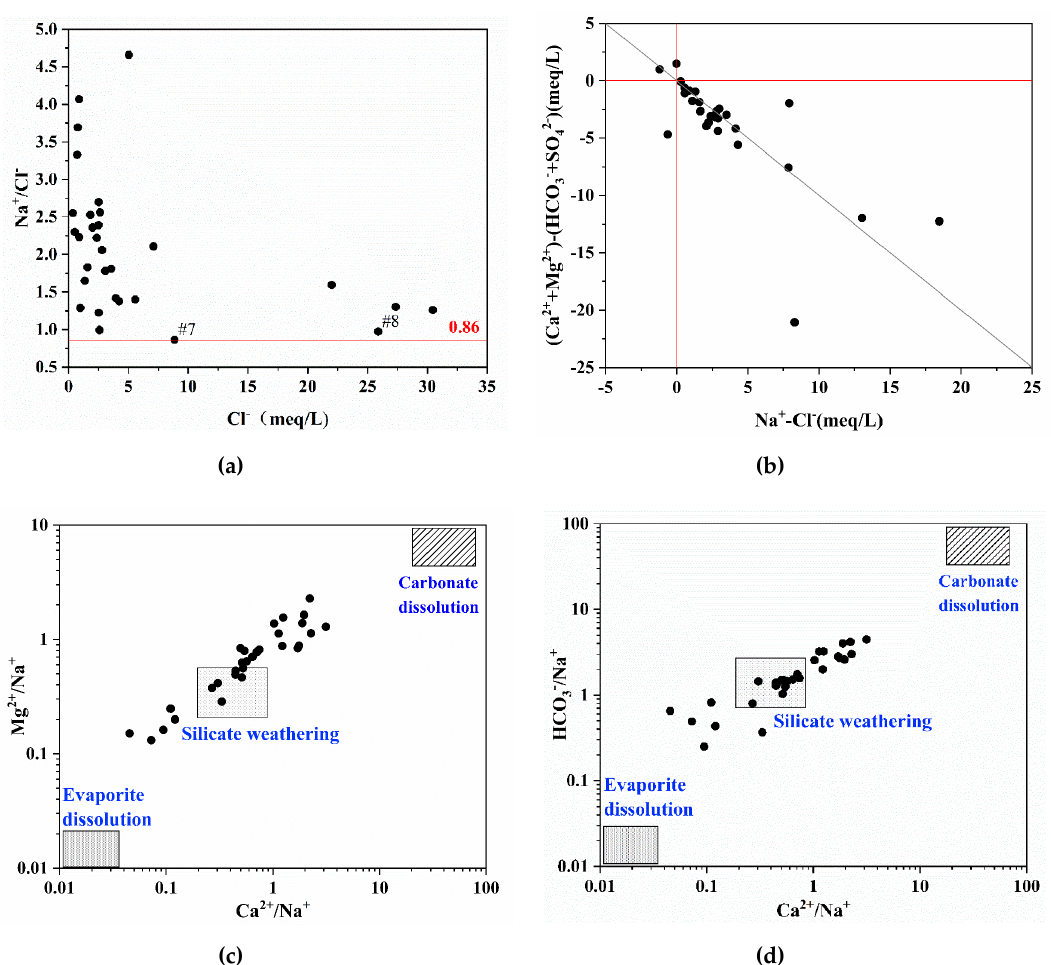
Figure 6. Scatter diagram of ( a ) Na + /Cl − vs. Cl − , ( b ) [(Ca 2+ + Mg 2+ ) − (HCO 3 − + SO 42 − )] vs. [Na + -Cl − ], ( c ) Mg 2+ /Na + vs. Ca 2+ /Na + , and ( d ) HCO 3 − /Na + vs. Ca 2+ /Na + .